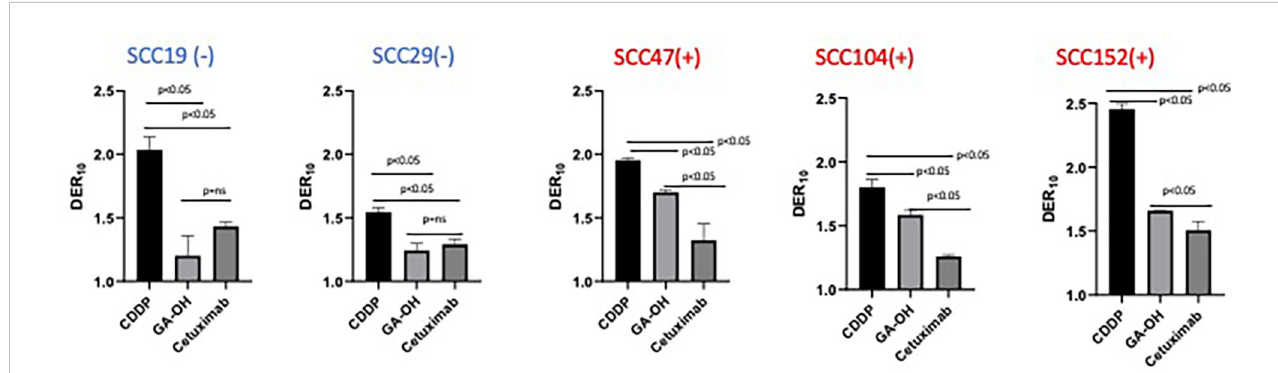
FIGURE 3 Relative degree of X-ray radio-sensitization by CDDP, GA-OH and cetuximab. Dose enhancement ratios (DER 10 ) of the 3 agents were determined at a cell surviving fraction (SF) of 0.1. Generally, CDDP shows the greatest sensitization and cetuximab shows the least sensitization, with no discrimination between HPV + and HPV - cell lines. GA-OH shows greater sensitization in HPV + cell lines than does cetuximab, though the magnitude of sensitization is less than that of CDDP. Values shown represent means ± standard deviation from 3 independent experiments.